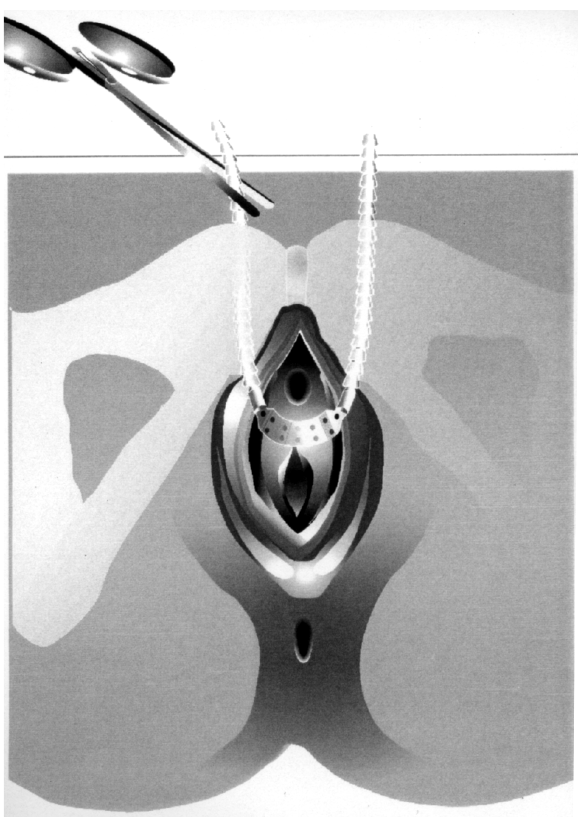
Figure 4 - A Metzenbaum scissors is placed between the tape and the urethra for proper tension adjustment.